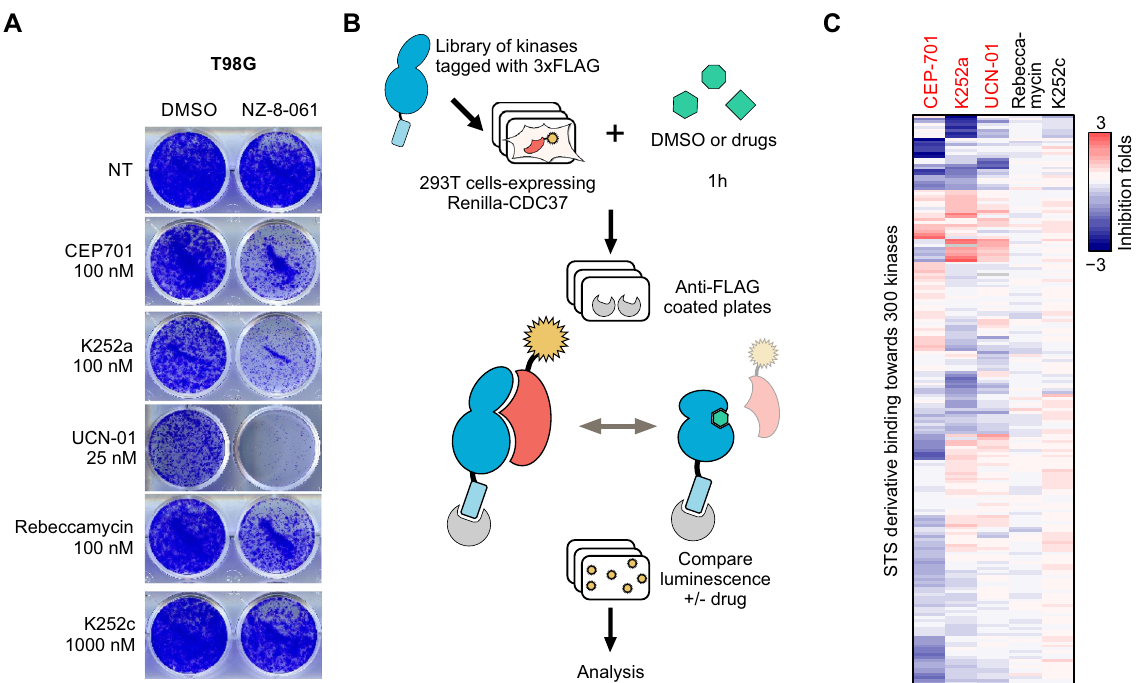
Figure 2. STS derivatives screening in Chaperone interaction assay. ( A ) Representative images of colony formation assay in T98G cells treated vehicle (DMSO) and NZ-8-061 in combination with STS derivatives. ( B ) A scheme of Chaperone interaction assay. Kinases tagged with 3xFLAG (blue), Renilla-CDC37 (red), tested drugs (green), anti-FLAG antibodies (grey). ( C ) Heat map representation of interaction of STS derivatives, CEP-701, K252a, UCN-01, rebeccamycin and K252c, with protein kinases by Chaperone interaction assay. STS derivatives causing synthetic lethality (red), no effect (black). Color scale bar indicates log2 fold changes of kinase/Cdc37 interactions between inhibitor and DMSO